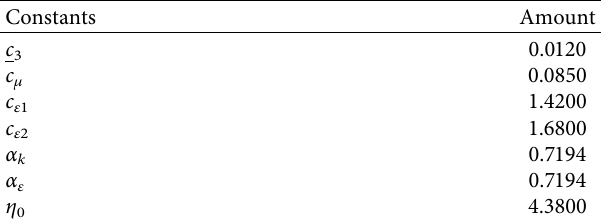
Table 1: Constants for k - ε -RNG turbulence